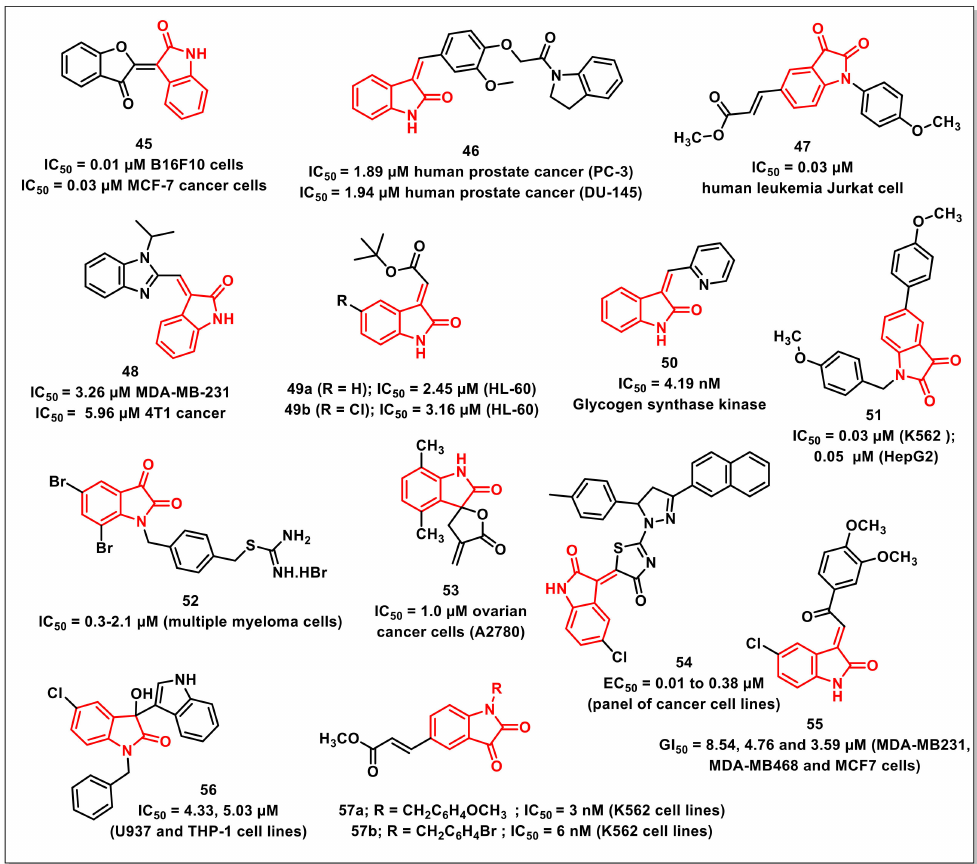
Figure 8. Miscellaneous examples of isatin-based compounds with promising antiproliferative/ anticancer